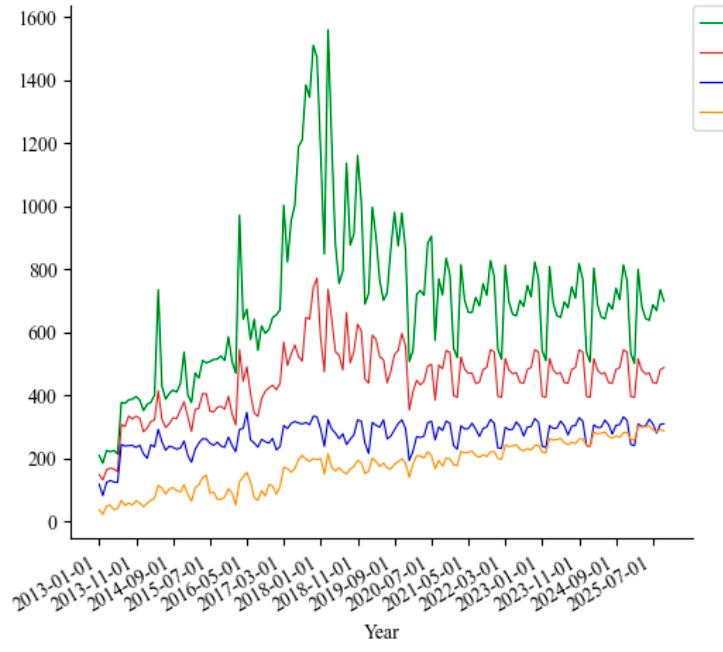
Figure 10. Forecast trend of “AI + education” attention in other cities.